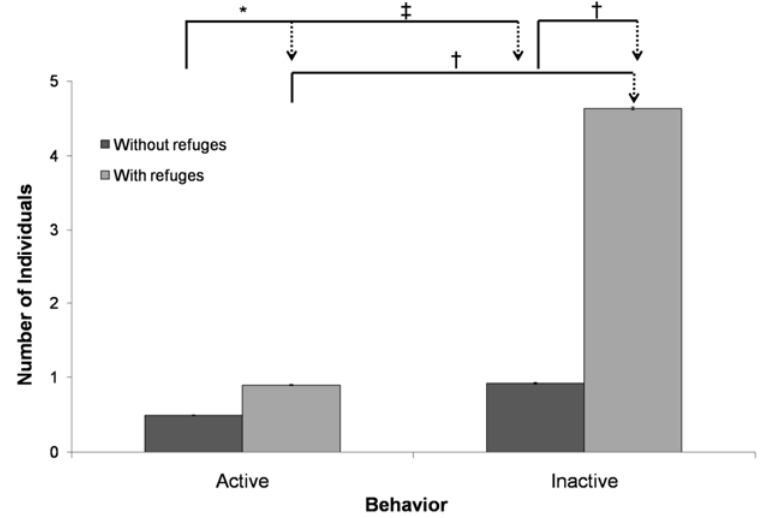
Figure 4. Mean numbers of individuals engaged in active and inactive behaviors in the categories “with refuges” (light bars) and “without refuges” (dark bars) during the four days of video recording in each condition for two hours. * p = 0.0019; † p < 0.0001; ‡ p = 0.0023.